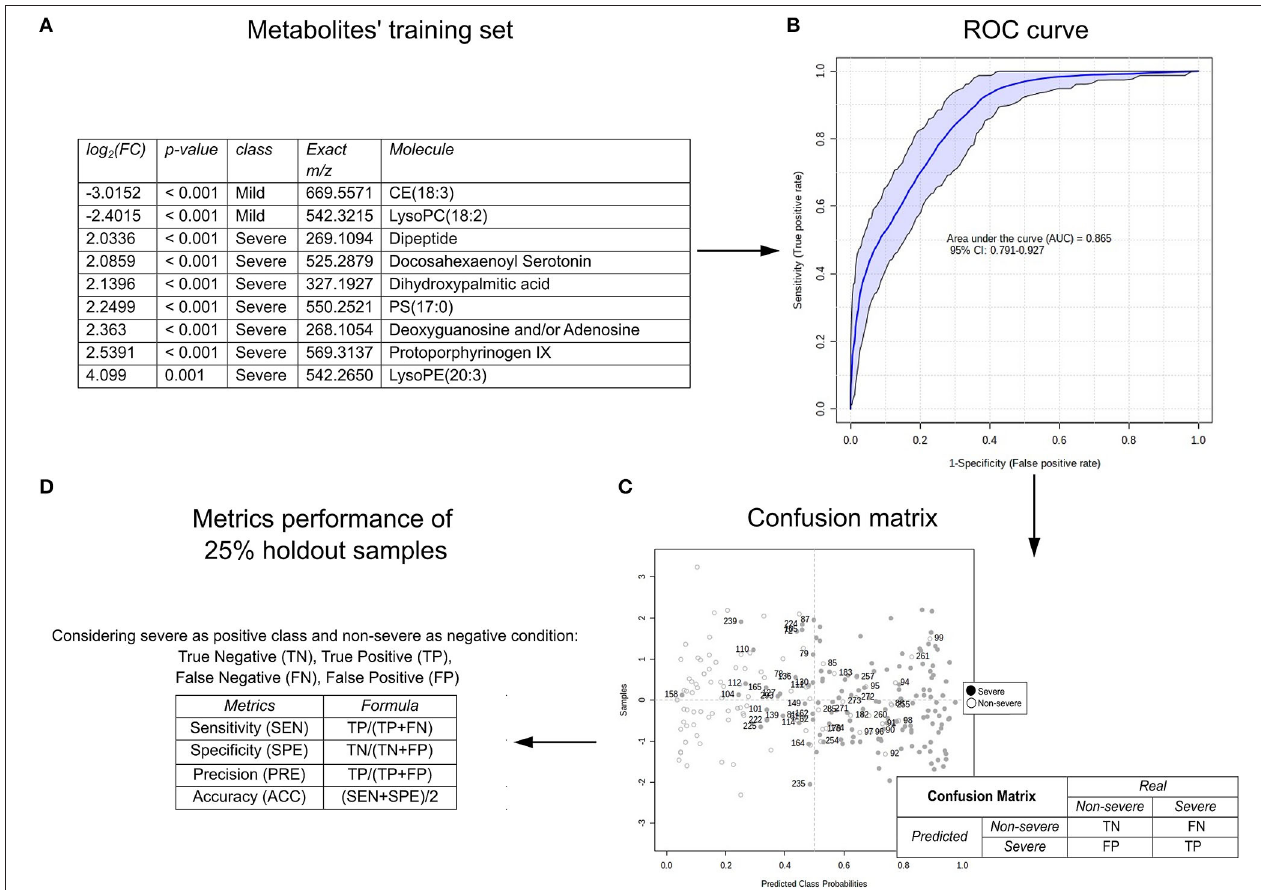
FIGURE 4 | An example of the prediction of SARS-CoV-2 infection severity according to the metabolomic profile of the plasma of the COVID-19 patients using the receiver operating characteristic (ROC) curve; (A) set of metabolites used for training; (B) ROC curve evidenced by the area under the curve (AUC) and CI 95%; (C) confusion matrix for calculating the proportion of false negatives, false positives, true negatives, and true positives; (D) performance metrics as sensitivity, specificity, accuracy, and precision. The figures were generated via MetaboAnalyst software v 4.0